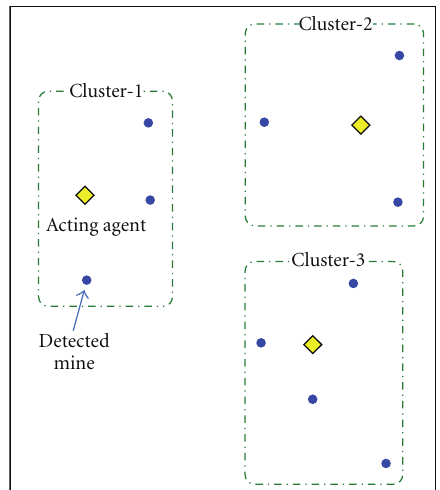
Figure 4: Clustered mine